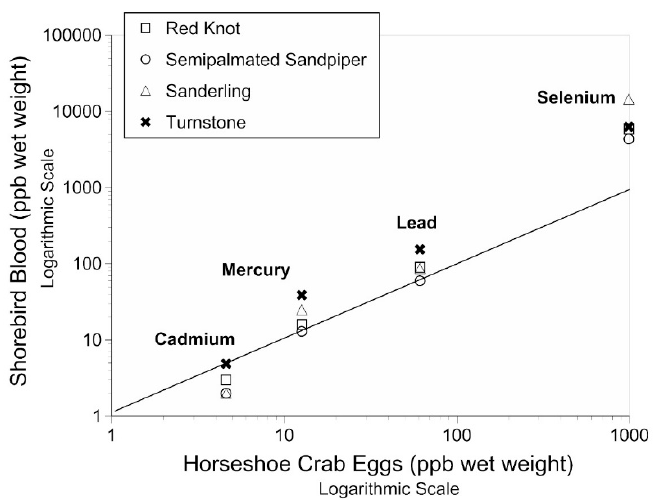
Figure 3. Relationship between the metals in horseshoe crab eggs and in the blood of four species of shorebird from Delaware Bay.